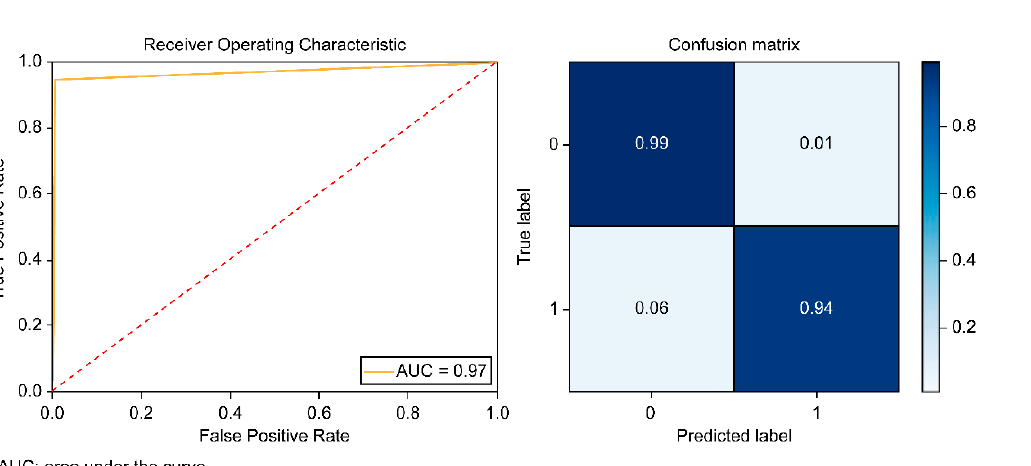
Table 3. Detection performance of PE from frontal chest X-rays